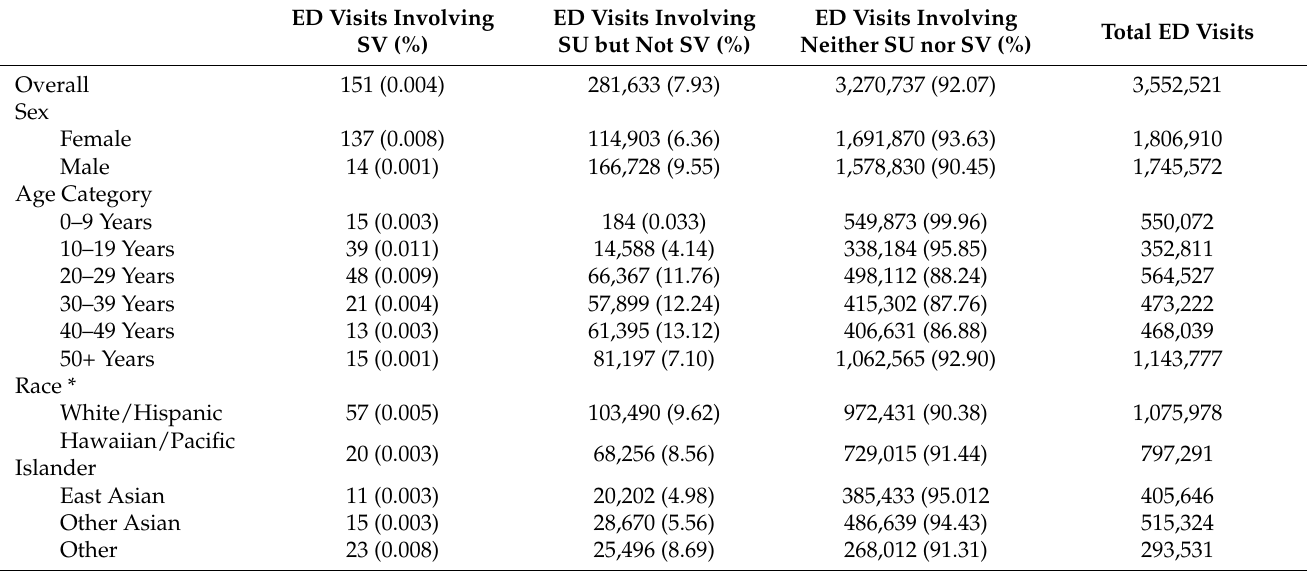
Table 5. ED Visits by Patient Sex, Age Group, and Race: HCUP Emergency Department Visits Database for Hawaii,